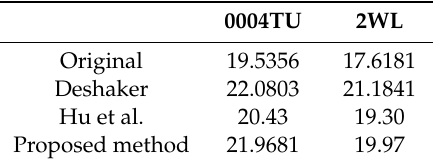
Table 2. ITF values of image sequences (dB).